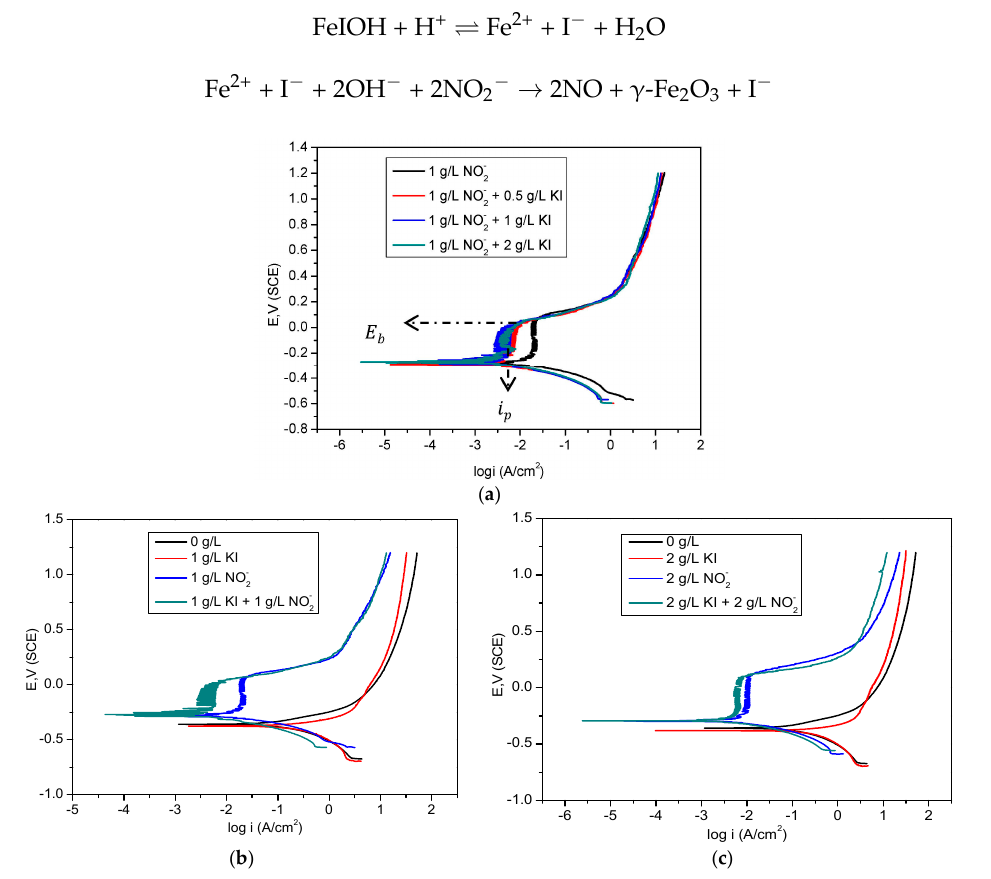
Figure 4. Polarization curves for mild steel in bicarbonate/chloride solution at 2000 rpm at room temperature: ( a ) in absence and presence of different concentrations of KI ( b , c ).